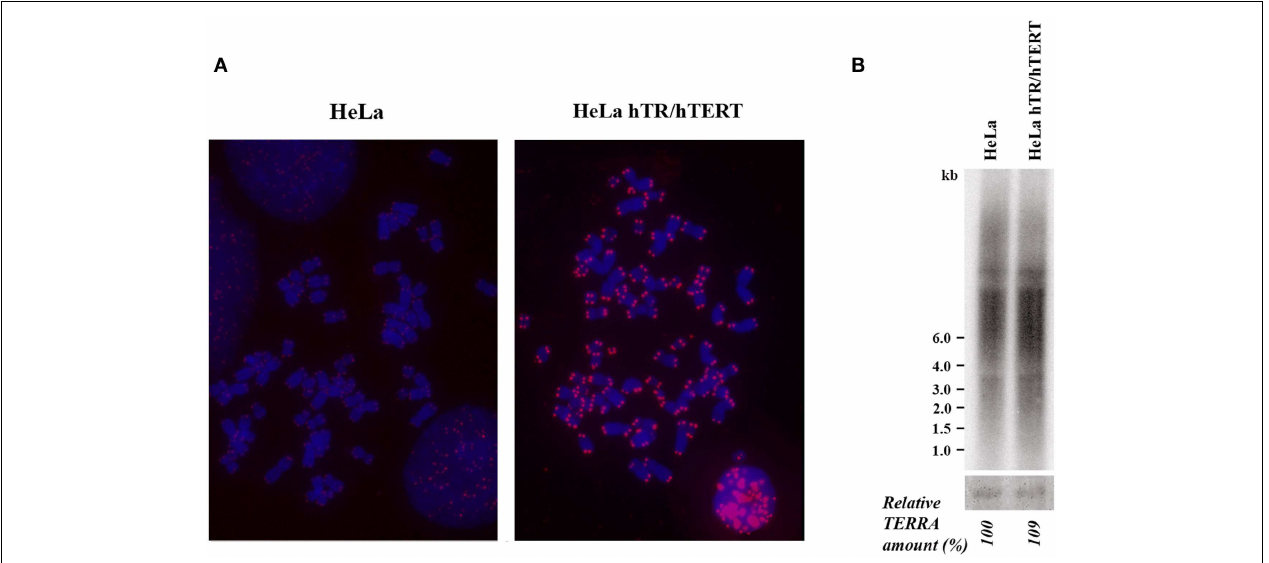
FIGURE 1 | (A) Telomere detection in HeLa and hTR/hTERT cells by PNA-FISH.Telomeric signals are in red, chromosomes are stained with DAPI. (B) Northern blot analysis ofTERRA expression in HeLa and hTR/hTERT cells. Ethidium bromide-stained 18S rRNA bands are shown at the bottom.